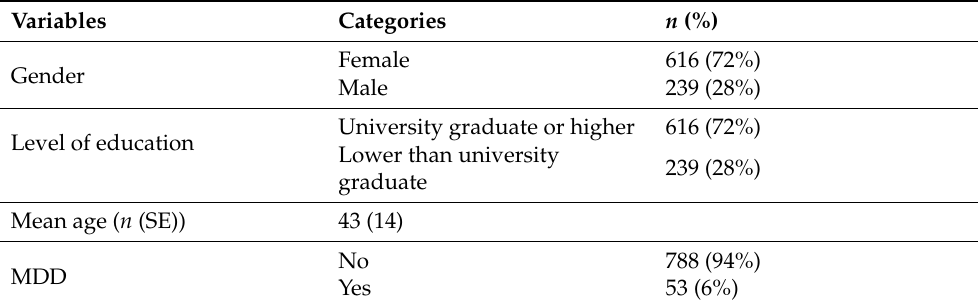
Table 1. Sociodemographic and clinical characteristics of the sample (n =